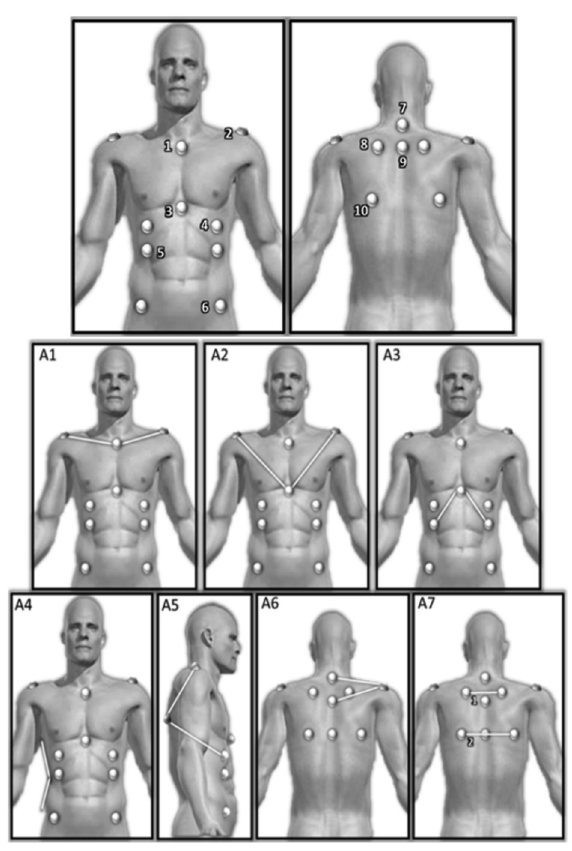
Figure 1 - 1. Manubrium of sternum; 2. Acromion of the scapula; 3. Xiphoid process of sternum; 4. Inframammary region (half the distance between nipple and last false rib); 5.Last false rib (intersection of nipple line with last false rib); 6.Antero-superior iliac spine (ASIS); 7. C7 spiny process; 8. Upper angle of the scapula; 9.T3 thymus process; 10. Lower angle of scapula. A1. Right (R) acromion/manubrium/left (L) acromion; A2. R acromion/xiphoid process/L acromion; A3. R Last false rib /xiphoid process/L last false rib; A4. Side deviation of the trunk; A5. Acromion/lower angle of scapula /inframammary; A6. C7/ acromion/T3; A7. Intersection of segments 1 and